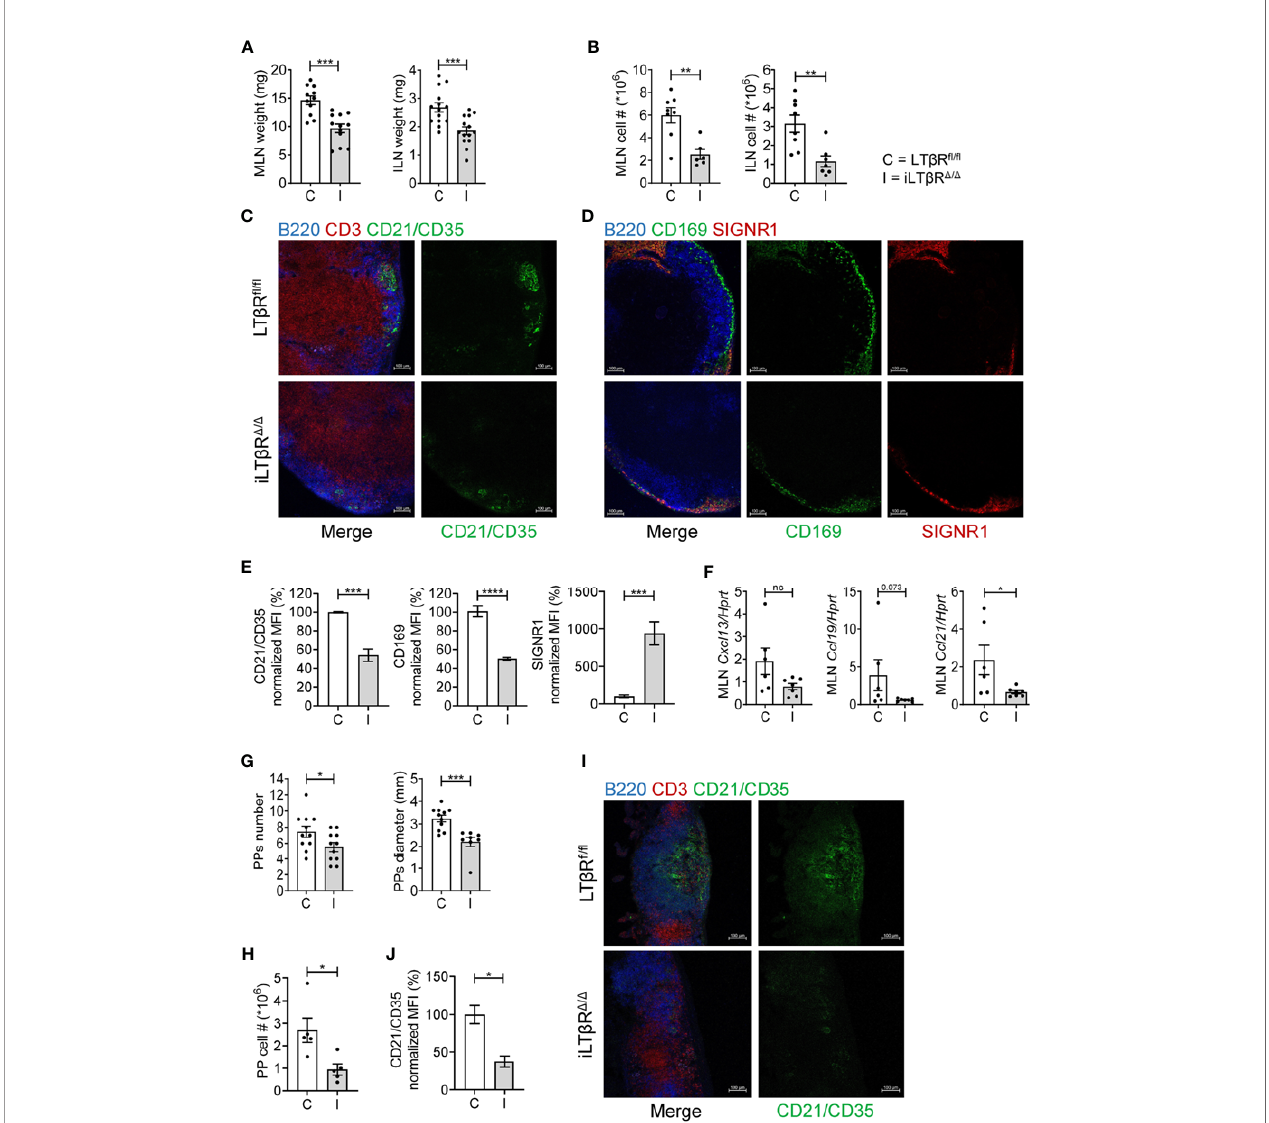
FIGURE 1 | LT b R signaling in adulthood is required for the maintenance of LNs and PPs. LT b R fl / fl (C) and iLT b R D / D (I) mice were treated with TAM by oral gavage one month before analysis. (A, B) MLN and ILN weights and total cell numbers. ILN weights are the combined weight for both ILNs isolated from each mouse. Per group, n=8-12 for MLN and n=7-14 for ILN. (C) Representative confocal images of frozen MLN sections stained with antibodies against B220 (blue), CD3 (red) and CD21/CD35 (green). (D) Representative confocal images of MLN sections stained with antibodies against B220 (blue), CD169 (green) and SIGNR1 (red). (E) Quanti fi cation of FDCs and SCS macrophages from panels C and D. SIGNR1 signal was quanti fi ed in the subcapsular sinus region. n=4 for each group. (F) CXCL13, CCL19 and CCL21 expression in MLN of LT b R fl / fl or iLT b R D / D mice determined by qPCR (n=6-7). (G) Number and diameter of PPs. n=11 mice per group. (H) Number of cells isolated from PPs of LT b R fl / fl or iLT b R D / D mice. (I) Representative confocal micrographs of frozen PP sections. n=5 mice per group. (J) Quanti fi cation of CR21/35 MFI within individual PPs. For panels I-J, n=3 per group. Scale bars are 100 m m for all images. Collective data from 4 experiments is shown for (A, B, G) . For (C – F, I, J) , data from 1 of 2 similar experiments are shown. For (H) , collective data from 2 of 3 experiments is shown. Signi fi cance was determined using Mann-Whitney or Unpaired t-test. Data shown are means ± SEM. Bars show the mean, symbols represent individual mice. Not signi fi cant (ns, p >0.05), *p < 0.05, **p < 0.01, ***p < 0.001, ****p <